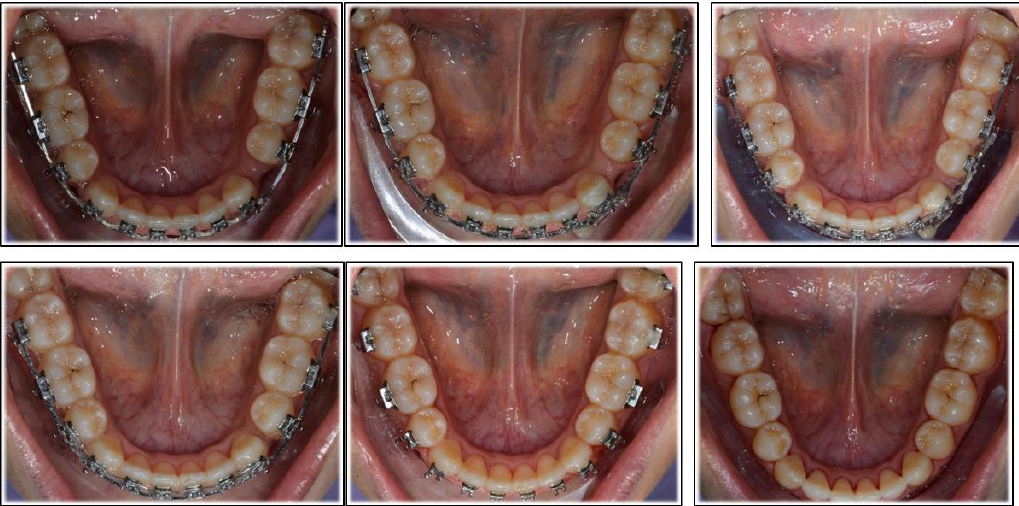
Figure 4. Intraoral treatment progress of the lower arch.